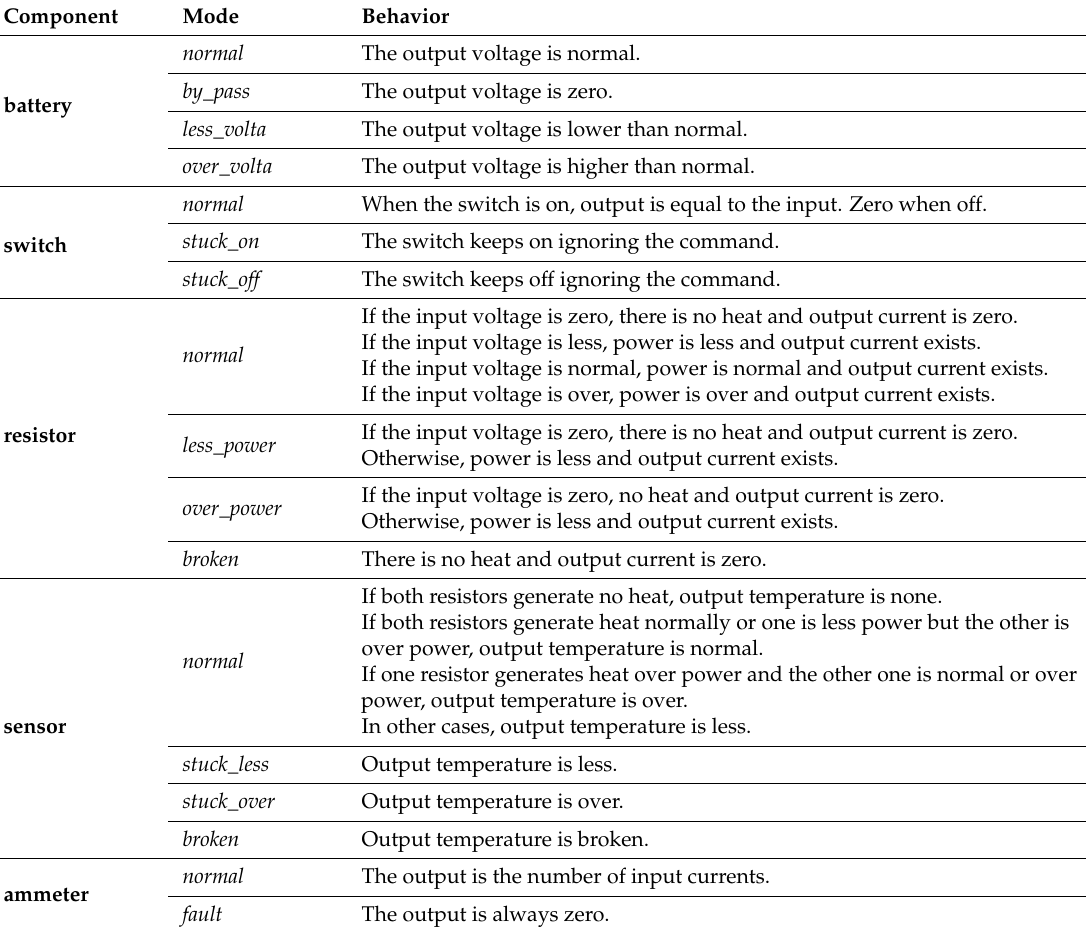
Table 2. Components, Modes and Behaviors.